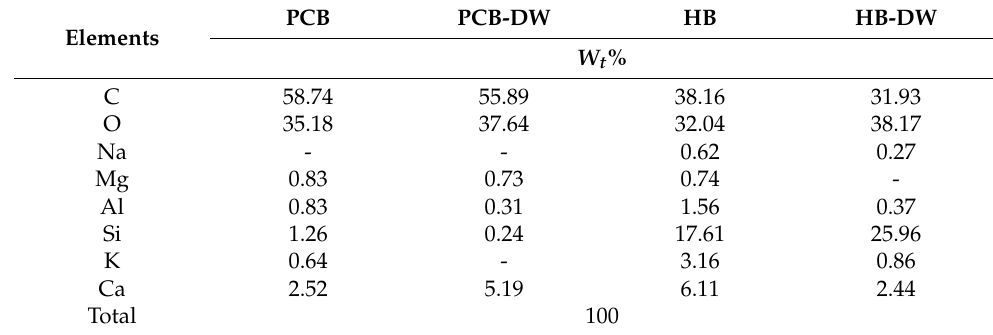
Table 4. Energy dispersive spectroscopy (EDS) contents of original and DW-leached Figure 5 . Cumulative low valence metal cations leached from PCB and HB in DW or AS. ( a ) Na + ;